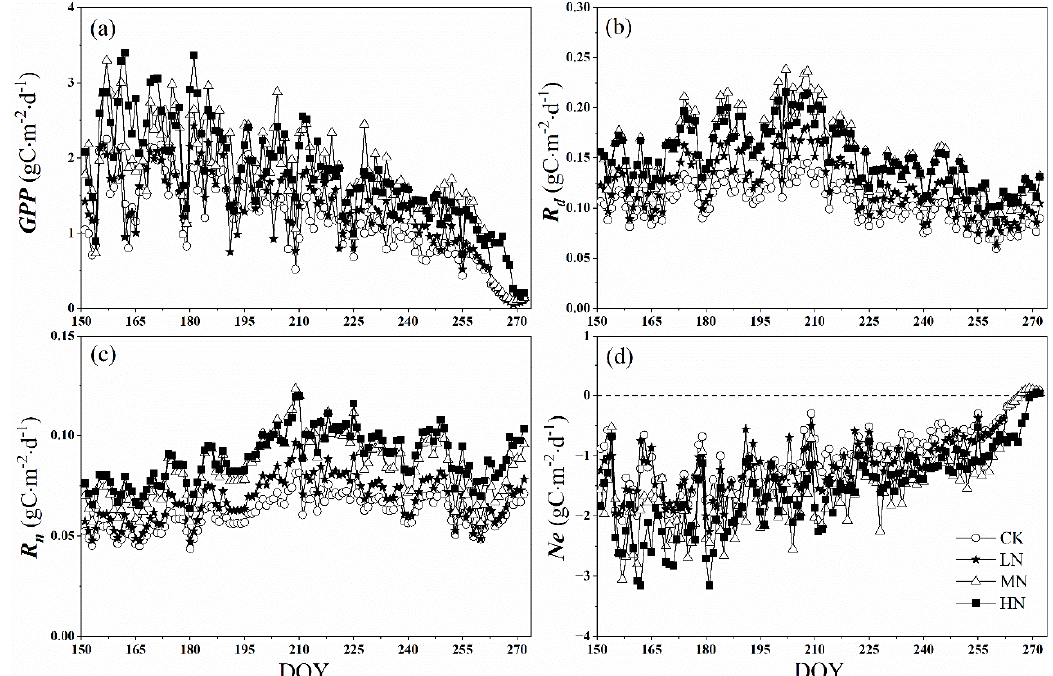
Figure 5. Daily sums of gross primary productivity ( GPP ) ( a ) the daytime respiration rate ( R d ), ( b ) the night-time respi- ration rate ( R n ), ( c ) and net crown CO 2 exchange rate ( Ne ), ( d ) after nitrogen addition and the control during the growing season (from 1 June to 30 September). CK, LN, MN and HN represent control (no nitrogen addition), low nitrogen addi- tion (23 kgN ‧ hm -2 ‧ a -1 ), medium nitrogen addition (46 kgN ‧ hm -2 ‧ a -1 ) and high nitrogen addition (69 kgN ‧ hm -2 ‧ a -1 ), respec- tively.